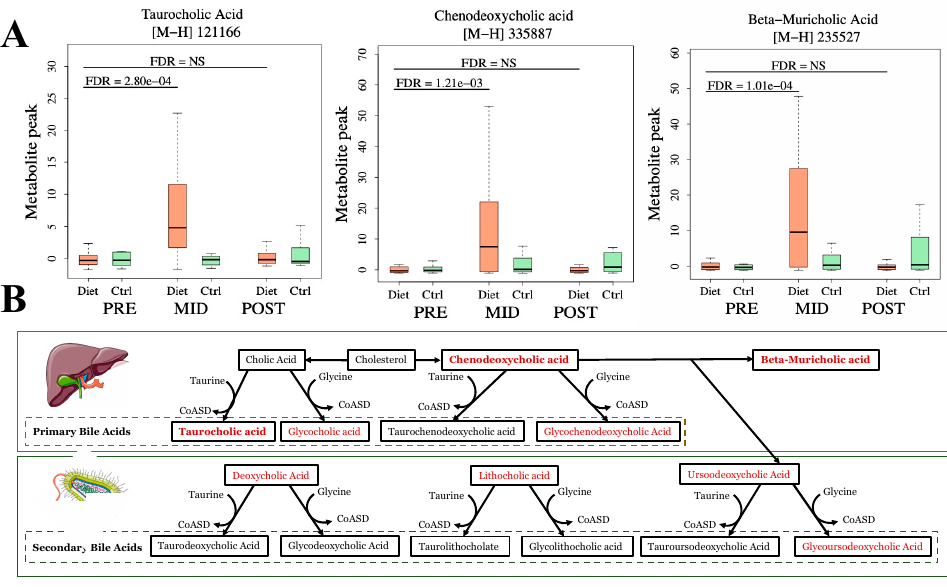
data. Table is ordered based on metabolite feature subclasses. Statistical significance was calculated using Generalized estimation equations (~Time + age). Significance threshold was set to FDR < 0.05, and all significant metabolite features from within diet group analysis and among specified sub- classes are depicted in Table 2. Analysis was adjusted with age as covariate. * Denotes metabolite features that were also significant (FDR < 0.05) and modulated in the same direction in the Control group analysis.